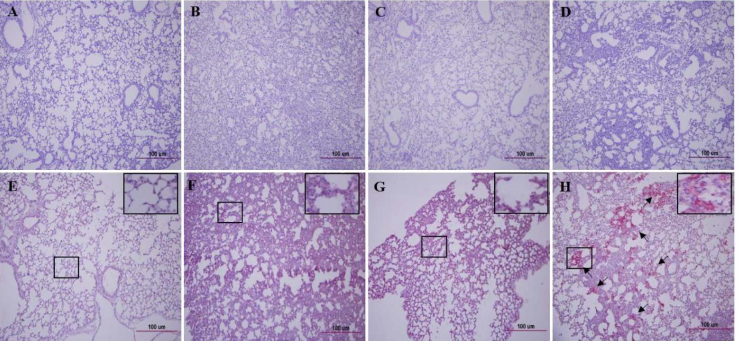
Figure 4. Lung histopathology and antigen-staining of the immunized and challenged hACE2 transgenic mice. Lung tissues (Figure 3E) of the immunized and challenged K18-ACE2 were stained withhematoxylinandeosin( A – D )( × 100)andSARS-CoV-2NPantibody( E – H )( × 100). ( A , E ),Lungtissue of PBS-mock mouse; ( B , F ) Lung tissue of the immunized mouse (2 × 10 3 pfu) and challenged with CoV-2-KCDC03 (2 × 10 4 pfu); ( C , G ), Lung tissue of the immunized mouse (2 × 10 4 pfu) and challenged with CoV-2-KCDC03 (2 × 10 4 pfu); ( D , H ), Lung tissue of PBS-mock and challenged mouse with CoV-2-KCDC03 (2 × 10 4 pfu). Arrow: positive antigen staining. Inlet ( ×